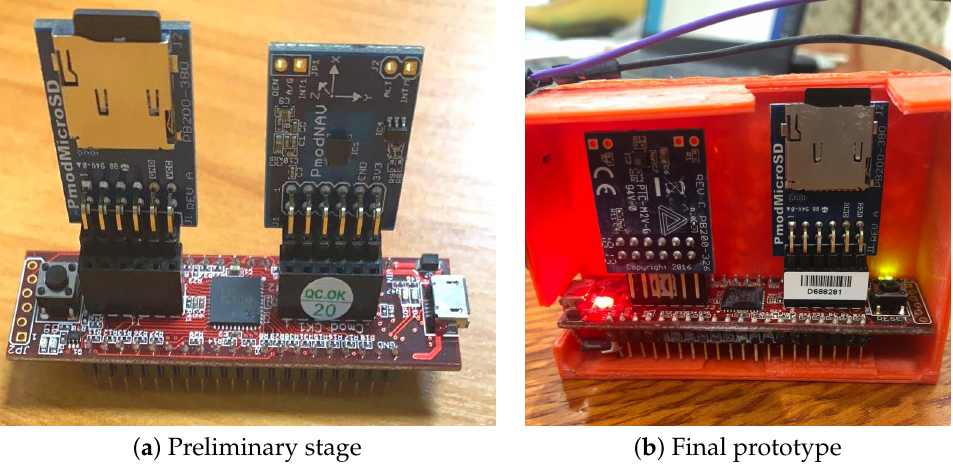
Figure 3. AWEAR bracelet developmental